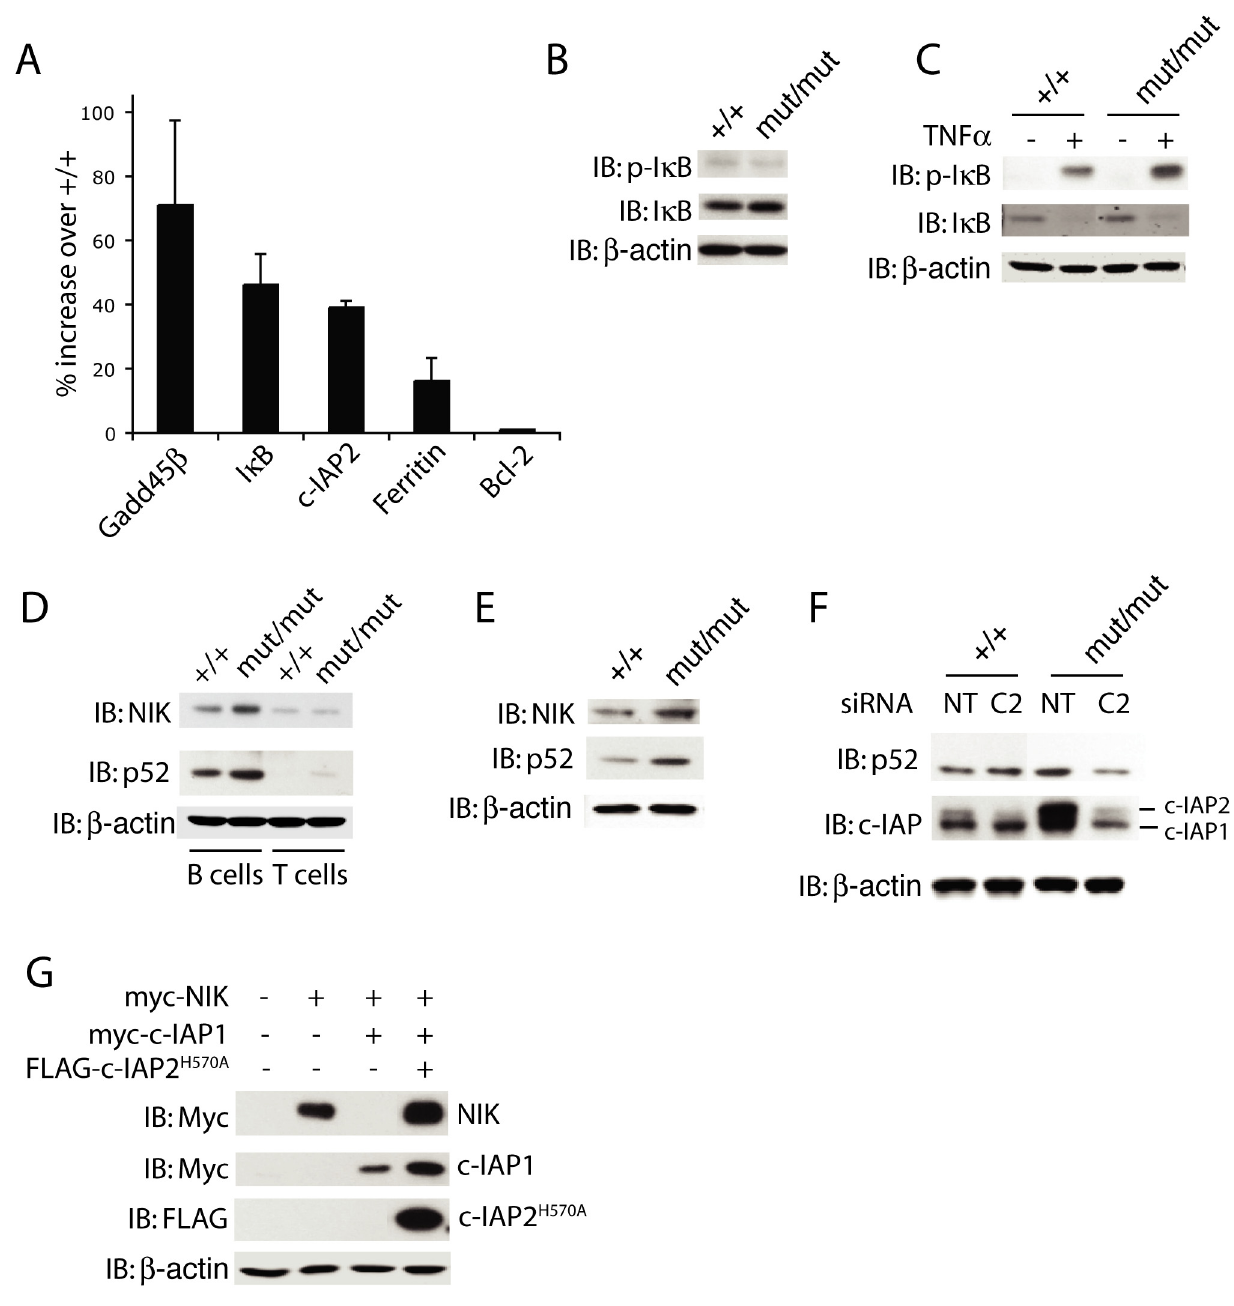
Figure 7. Elevated non-canonical NF- k B activation in c-IAP2 H570A/H570A cells. (A) NF- k B target gene expression in WT ( + / + ) and c-IAP2 H570A/H570A B cells determined by real-time PCR. Bars represent the mean increase of each mRNA in c-IAP2 H570A/H570A cells from three independent experiments. The error bars represent thestandard error of themean. (B) Immunoblotting of phospho-I k B and I k B in lysates of + / + andc-IAP2 H570A/H570A (mut/mut)B cells. b - actin expression was used as a loading of control. (C) Immunoblotting of phospho-I k B and I k B levels in lysates of unstimulated + / + and mut/mut MEFsasin (B). Lysates of cells stimulated with TNF- a (10 ng/ml for 5 min) were blotted in parallel as a positive control for the phospho-I k B antibody. (D) Immunoblotting of NIK and p52 in lysates prepared from + / + and mut/mut B and T cells. b -actin expression was used as a loading of control. (E) Immunoblotting of NIK and p52 in lysates prepared from + / + and mut/mut MEFs as in (D). (F) Knockdown of c-IAP2 in + / + and mut/mut MEFs. Cells were transfected with non-targeting (NT) or c-IAP2 siRNA (C2) for 24 h, harvested, and lysed. c-IAP2 and p52 levels were determined by immunoblot. b -actin expressionwas usedas aloadingofcontrol.The laneshavebeenreorderedforclarity.(G)293T cells weretransfectedwithexpressionvectorscontainingthe indicated cDNAs and immunoblotted for the respective peptide tags and b